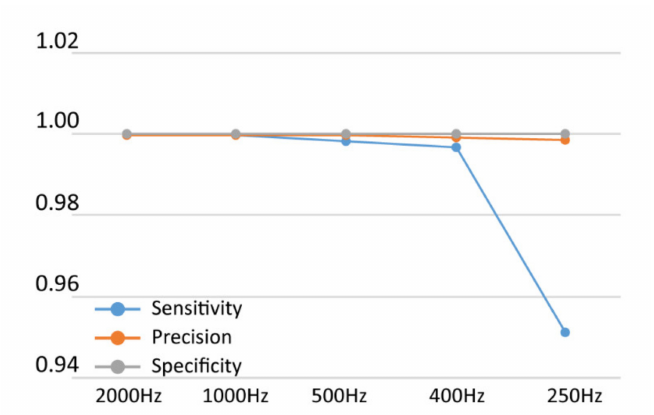
Figure 5. Sensitivity, precision and specificity of R-peak detection of the same ECG file at di ff erent sample rates analyzed with our custom